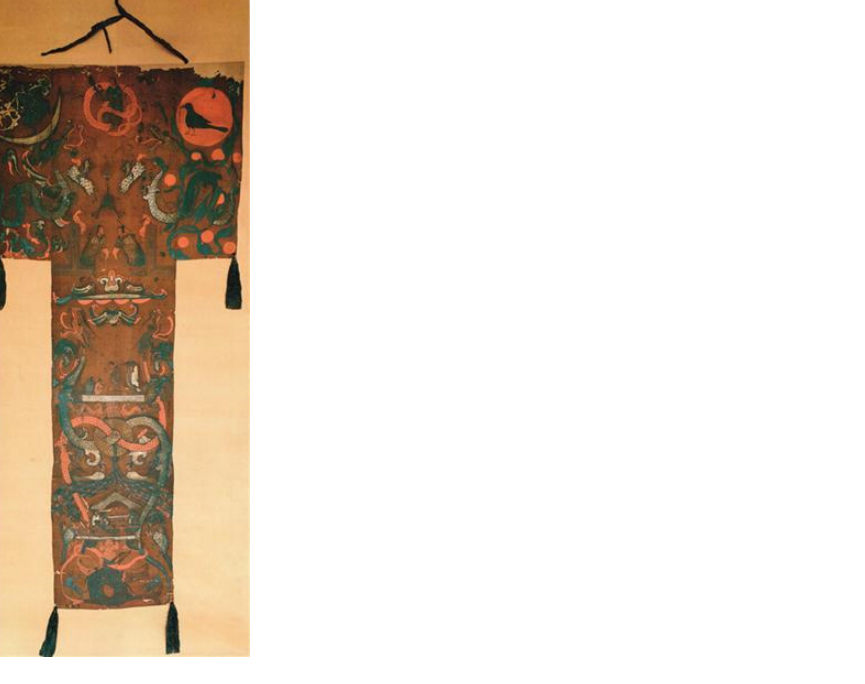
Figure 2. T-shaped silk painting from Tomb 1 in Mawangdui, Western Han dynasty.